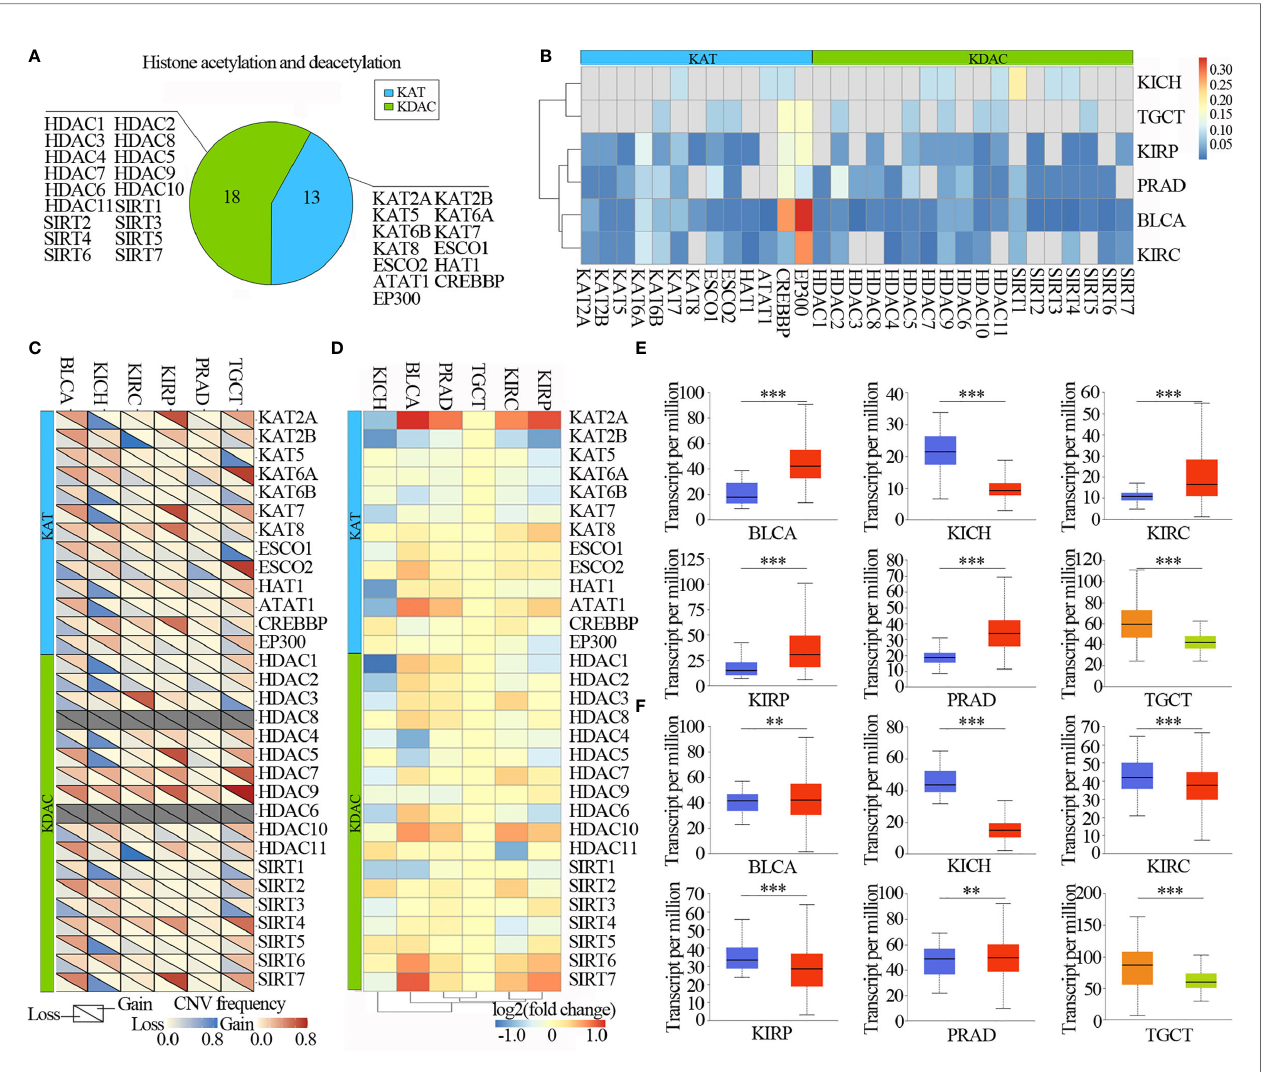
FIGURE 2 | Urilogical tumors genetic and expression alterations of 31 lysine acetylation regulators. (A) The proportion of lysine acetylation regulators. (B) The mutation frequency of lysine acetylation regulators in 6 cancer types. (C) The CNV alteration frequency of lysine acetylation regulators in 6 cancer types. (D) The gene expression alterations of lysine acetylation regulators in TCGA database. (E, F) Box plots showing the expression distribution of KAT2A (E) and HAT1 (F) across tumor and normal samples in 6 cancer types. The blue color represents normal sample, the red color represents tumor sample, the blue color represents seminoma and the light green represents non-seminoma. **P < 0.01; ***P <